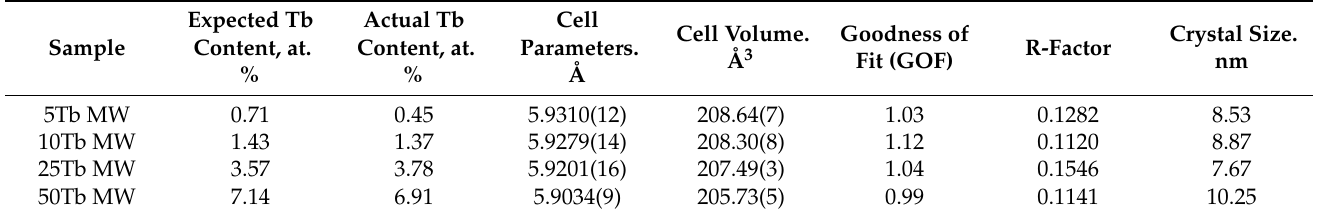
Table 3. Cell parameters of the BaGdF 5 : x%Tb 3+ samples calculated from the full profile analysis in the Jana2006 software and crystal size calculated using the Scherrer equation.